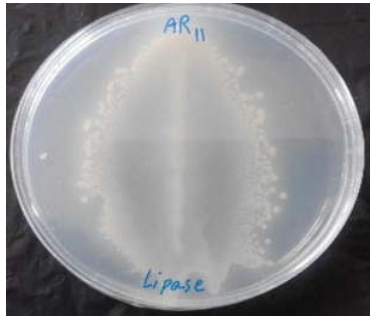
Fig. 2. Lipase produced by isolated